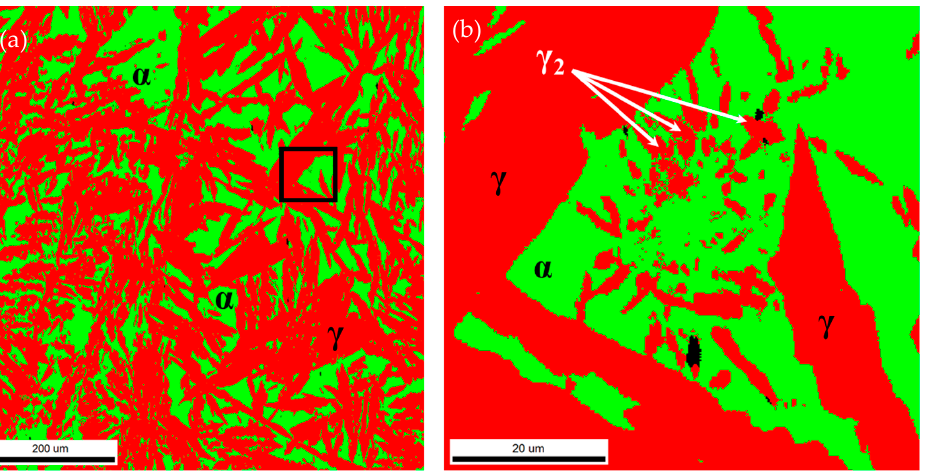
Figure 13. EBSD phase maps from Wall 1 showing the presence of secondary austenite. Ferrite is green, austenite is red. ( b ) is close-up of square in ( a ). Arrows point to γ 2 .